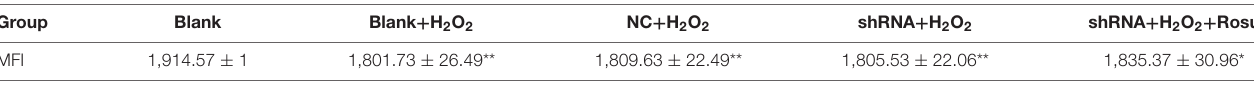
TABLE 1 | Mean fluorescence intensity (MFI) of mitochondrial membrane potential in different groups. Group Blank Blank + H 2 O